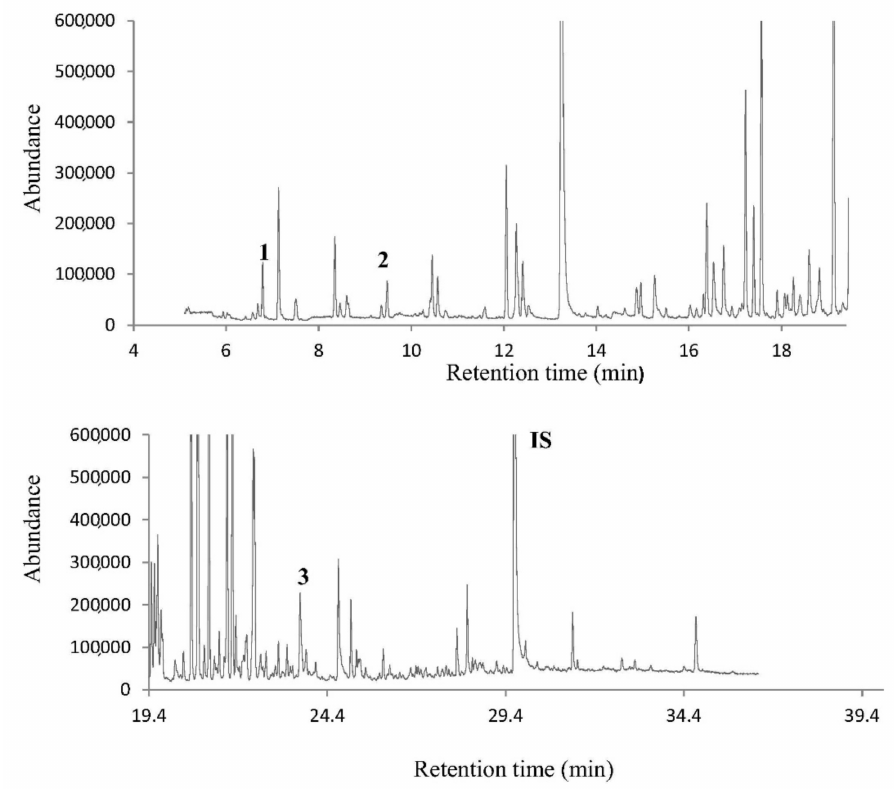
Figure 2. A typical gas chromatogram of citrus honey from Egypt. Possible volatile markers of geographical origin are indicated in bold. 1: heptane, 2: 2-methyl-butanal, 3: methyl anthranilate. IS: internal standard. Reprinted with permission from ref. [48]. Copyright 2016 Copyright Elsevier